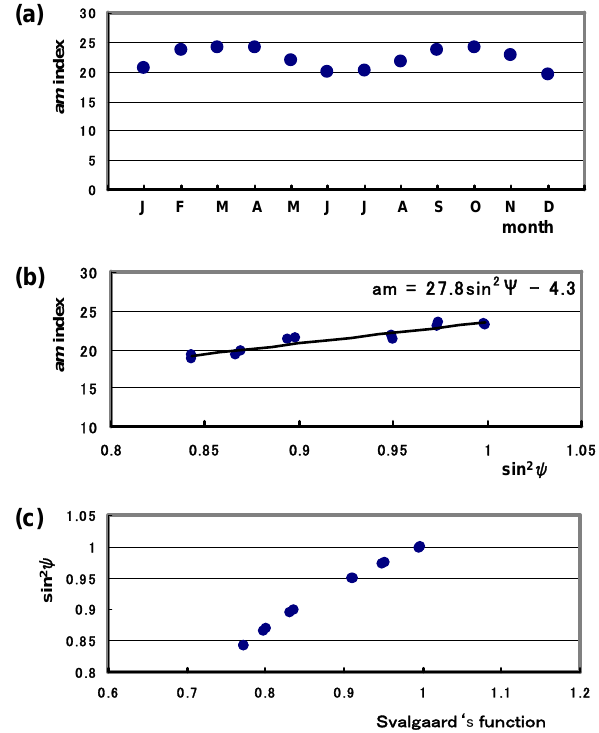
Fig. 4. Relationship between monthly averages of am index and sin 2 ( ψ) . (a) Semi-annual variation in monthly am averages for the period 1961–2007. (b) Monthly average of the am indices ver- sus sin 2 ( ψ) at the middle day of each month. (c) Comparison of sin 2 ( ψ) with Svalgaard’s empirical